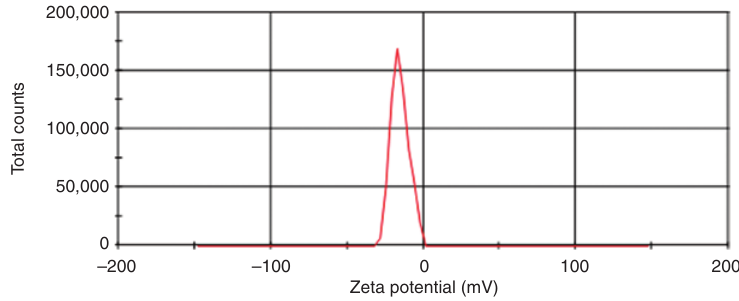
Figure 7: Zeta potential distribution of synthesized ZnO NPs at optimum conditions.